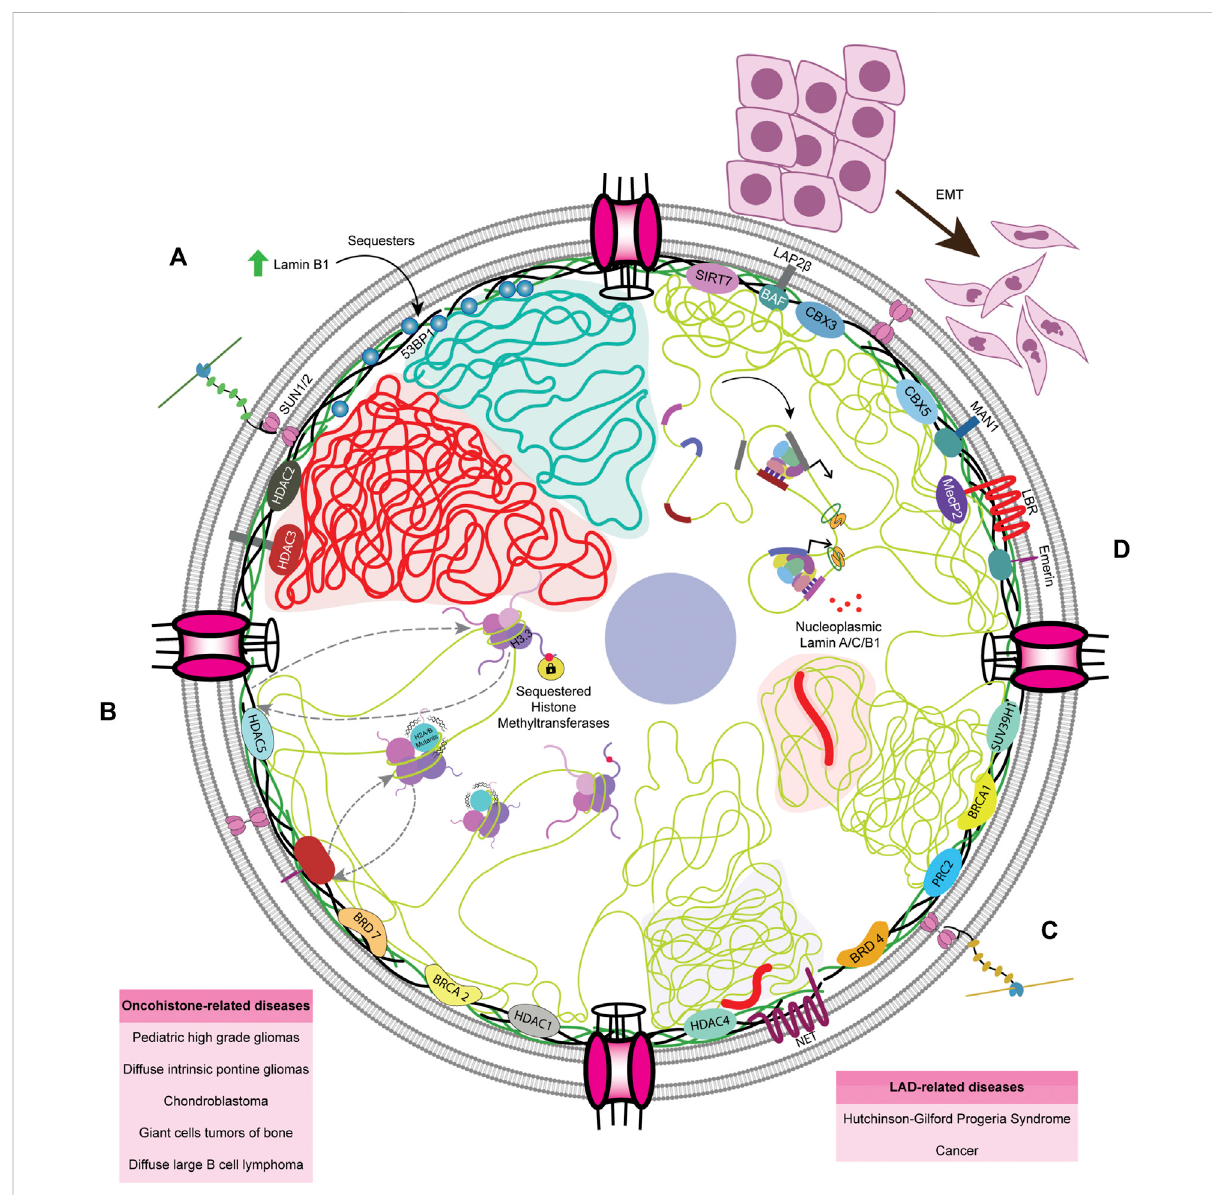
FIGURE 5 Lacunae in the fi eld of genome organization and nuclear envelope (A) Lamin B1 is upregulated in most cancers, as per TCGA data, and overexpression of Lamin B1 expression sequesters 53BP1, a major orchestrator of NHEJ pathway. The precise mechanisms as to how cancer cells overcome 53BP1 sequestration is unknown (B) Incorporation of both tail and globular domain mutants leads to dysregulated gene expression through various mechanisms, though it remains unclear whether nuclear lamina has any role in either mitigating or worsening it. Globular domain mutations, when associated with the LADs, could be altering the spatial localization of gene loci. (C) The nuclear envelope maintains heterochromatin. LADs form a signi fi cant portion of the human genome and are regulated by the lamina and its associated complexes, the deregulation of which often leads to HGPS and cancer (D) Furthermore, in EMT and cancer progression, phosphorylated lamin A/C and B1 are associated with enhancer sequences, but the role of this association remains to be